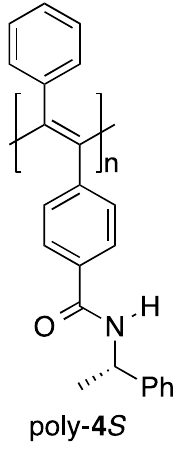
Figure 1. The structure of poly- 4 S .